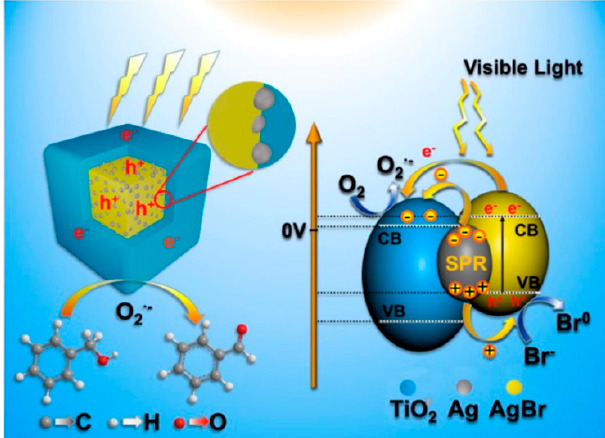
Figure 24. Proposed reaction mechanism from benzyl alcohol to benzaldehyde over the sandwich structured AgBr@Ag@TiO 2 under visible light irradiation. Reprinted with permission from reference [165]. Copyright 2016 Elsevier.